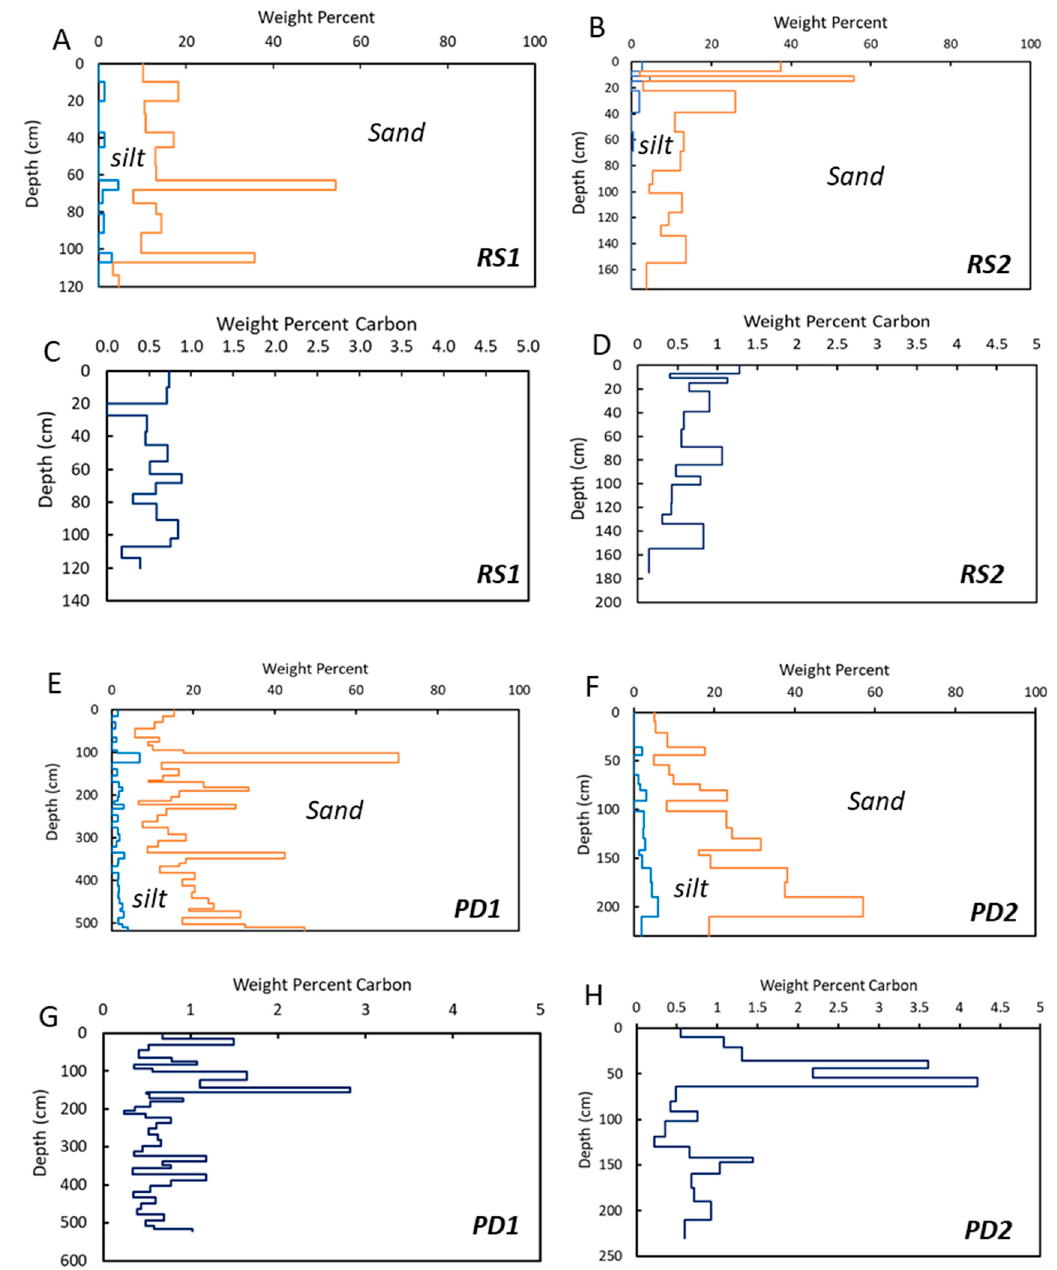
Figure 4. Variations in the grain size distribution and carbon content of the paleoflood deposits. Grain size distribution at RS1 ( A ), RS2 ( B ), PD1 ( E ), and PD2 ( F ); Organic matter content at RS1 ( C ), RS2 ( D ), PD1 ( G ) and PD2 ( H ).